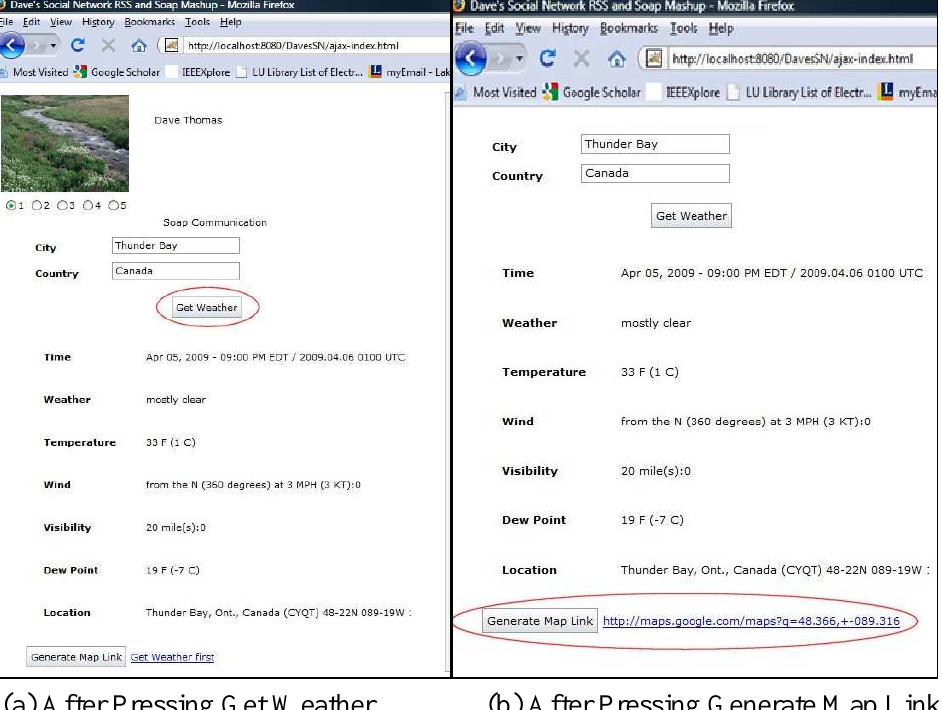
Figure 6. Mashing up the Weather Information then the City Map.